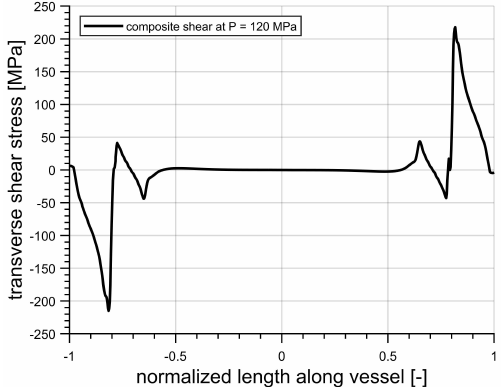
Figure 14. Shear stresses the helical layer of the composite.